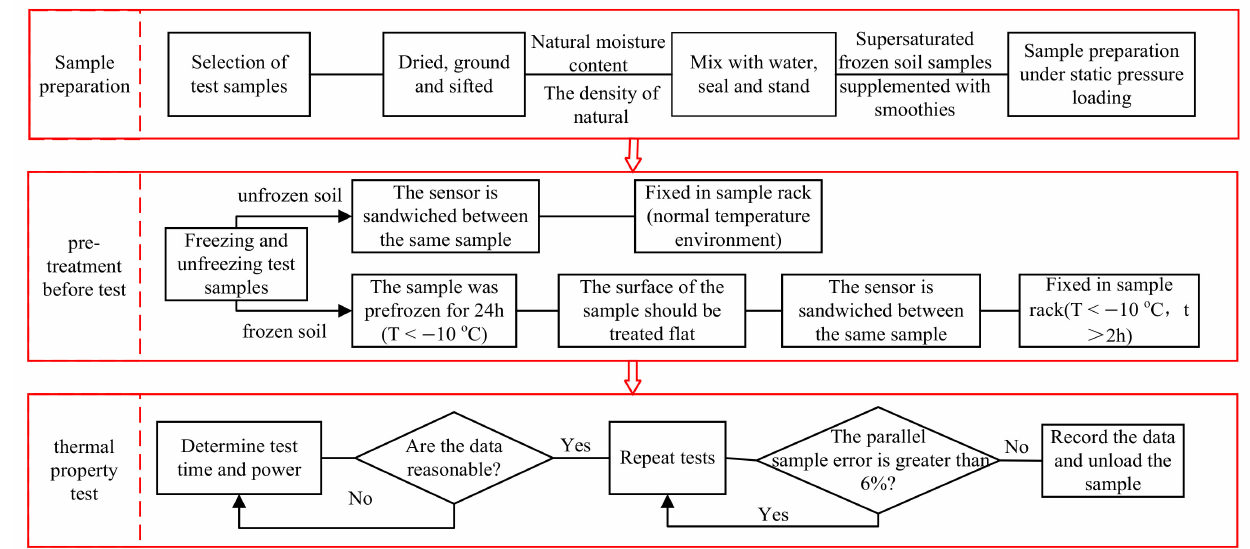
Figure 5. Experimental procedures of thermal conductivity.